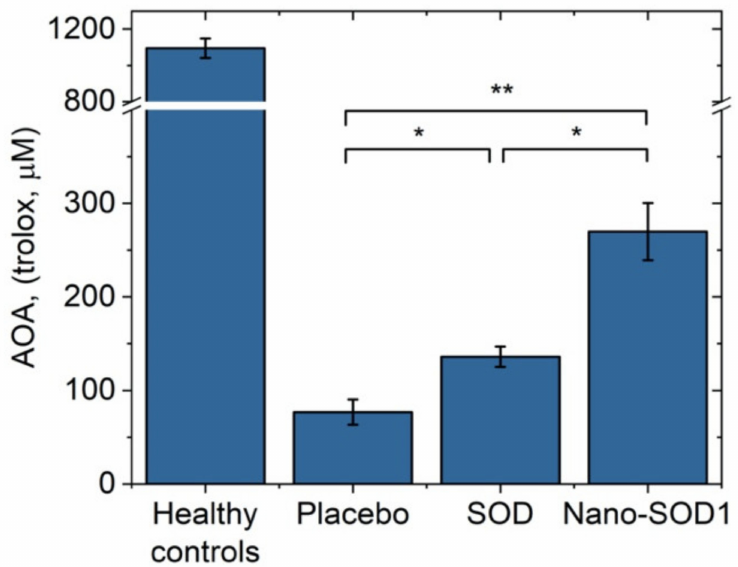
Figure 8. Antioxidant activity in the intraocular fluid of rabbits on the 8th day of experimental immunogenic uveitis (mean ± SD). ** p < 0.01; * p < 0.05 (Mann–Whitney